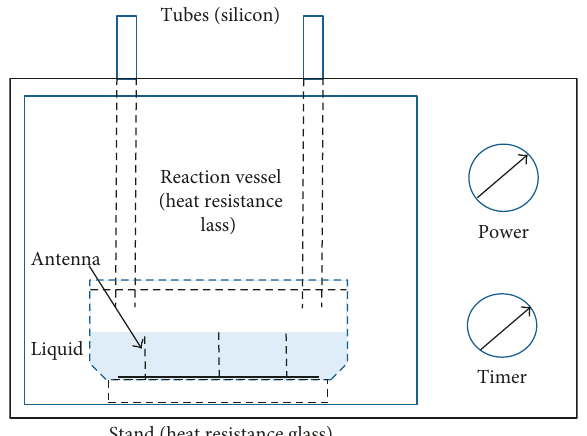
Figure 2: A typical front view schematic of a converted microwave oven for liquid processing. For clarity, the auxiliary gas lines outside the ovens are not